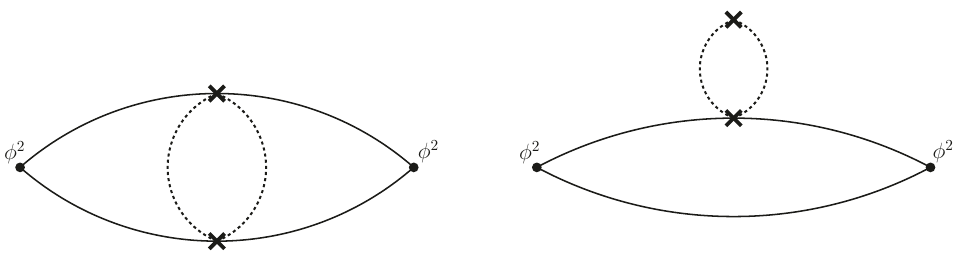
Figure 7 . Two possible corrections to the e(cid:11)ective lightcone Hamiltonian due to four-point func- tions. By inserting a complete set of states, we (cid:12)nd that the spectral decomposition of the left diagram survives in the in(cid:12)nite momentum limit, such that there are no analytic terms in q i + and thus no contributions to the e(cid:11)ective Hamiltonian. The spectral decomposition of the right dia- gram vanishes in this limit, giving rise to delta function singularities which correct the lightcone